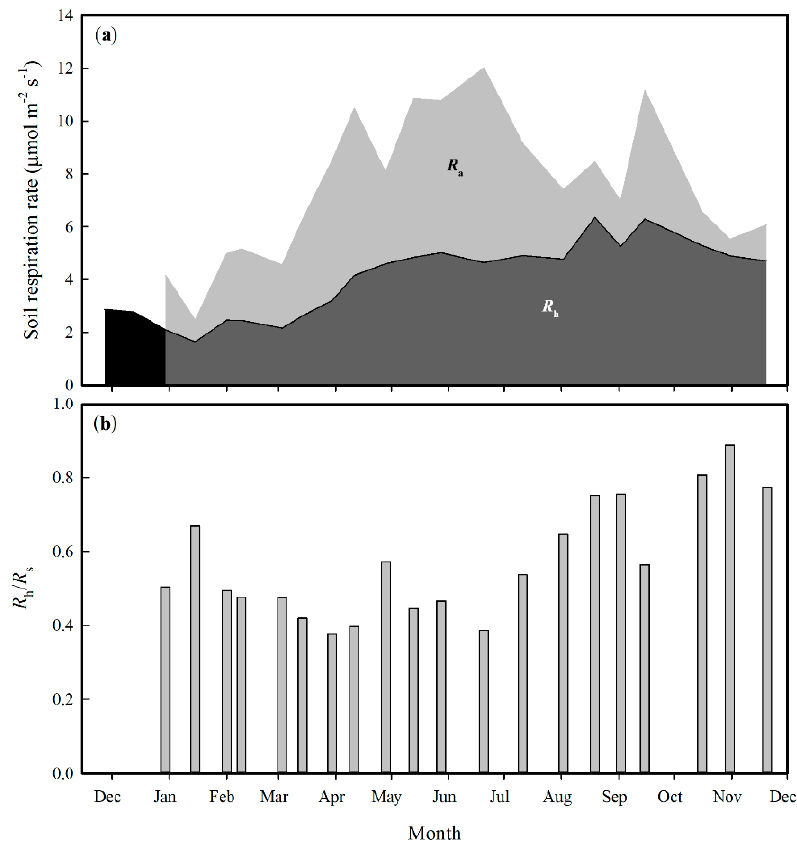
Figure 8. Temporal dynamics of soil respiration rate and its components ( a ), and of R h / R s ( b ). R a :